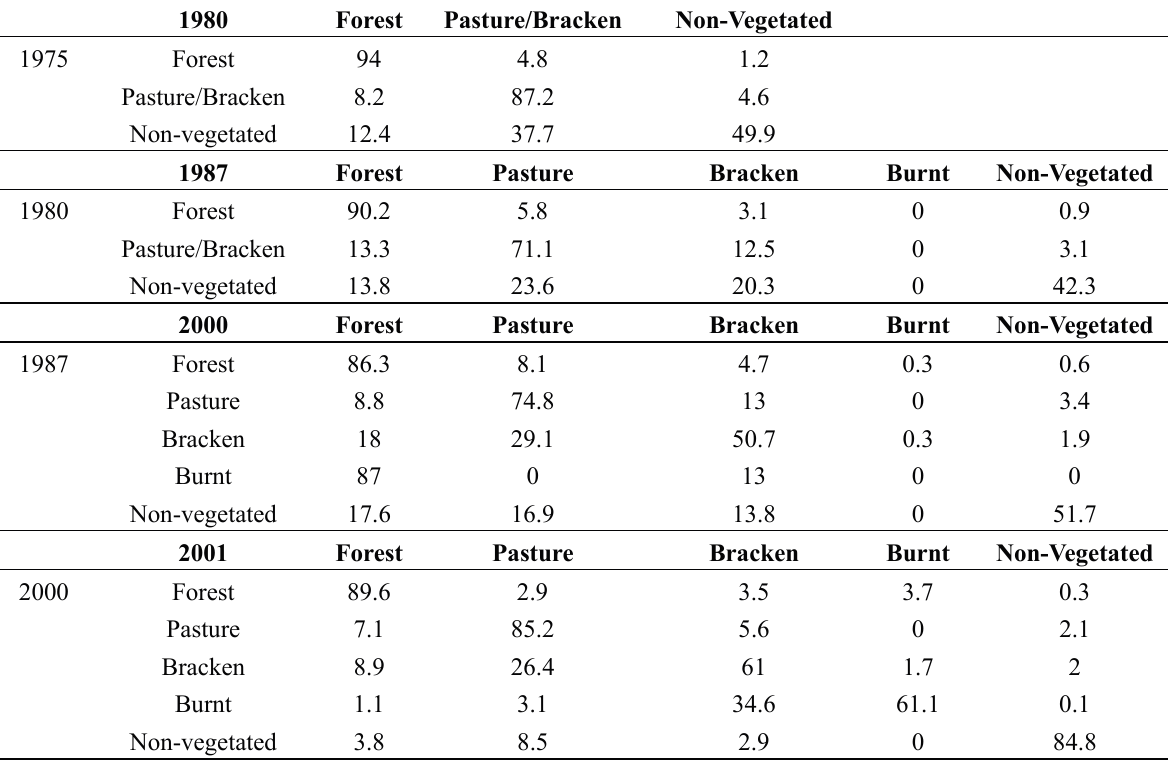
Table 7. Transition matrices of land cover change in the periods 1975–1980, 1980–1987, 1987–2000, and 2000–2001.